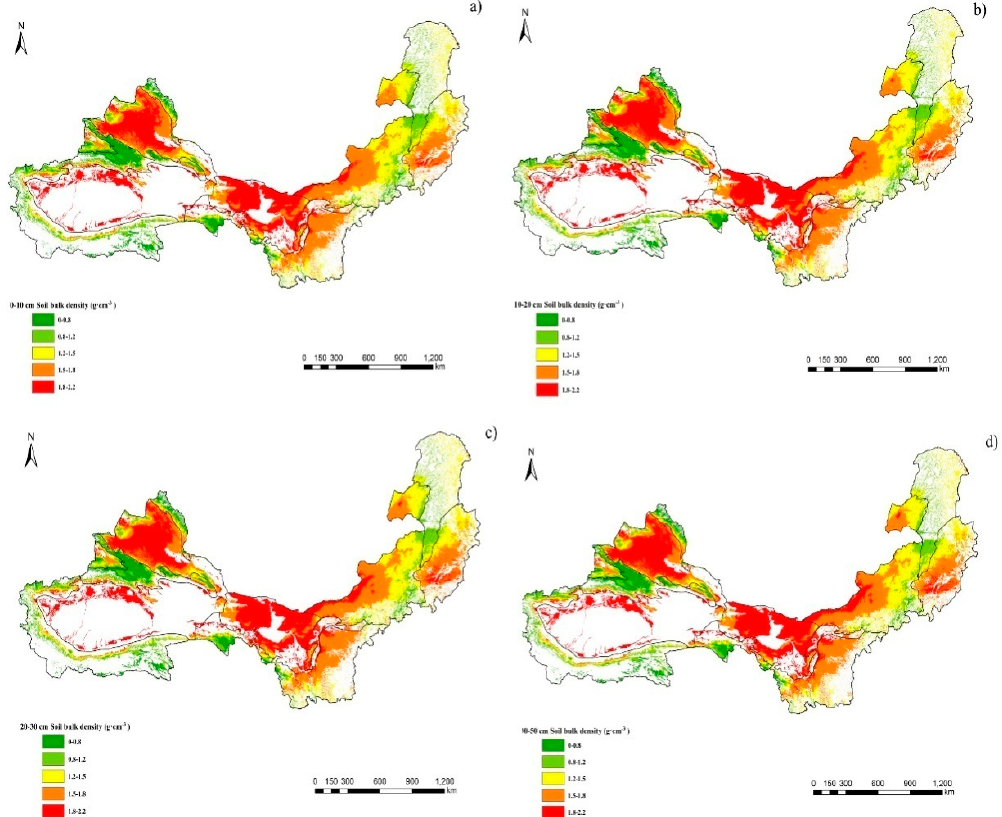
Figure 3. Spatial distribution mapping of stratified soil bulk density of northern grasslands: ( a ) 0–10 cm soil bulk density; ( b ) 10–20 cm soil bulk density; ( c ) 20–30 cm soil bulk density; ( d ) 30–50 cm soil bulk density.